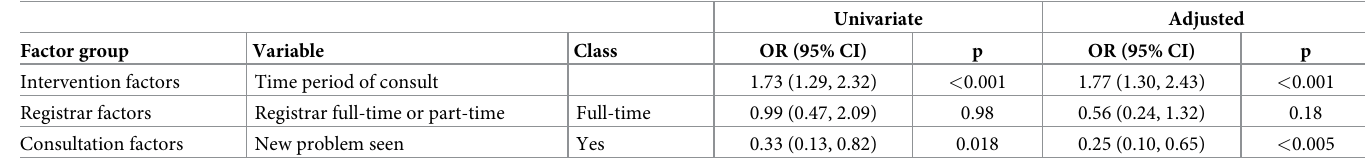
Table 4. Multivariable associations of GP registrar initiation of ‘new’ diabetes medications compared to sulphonylureas over time